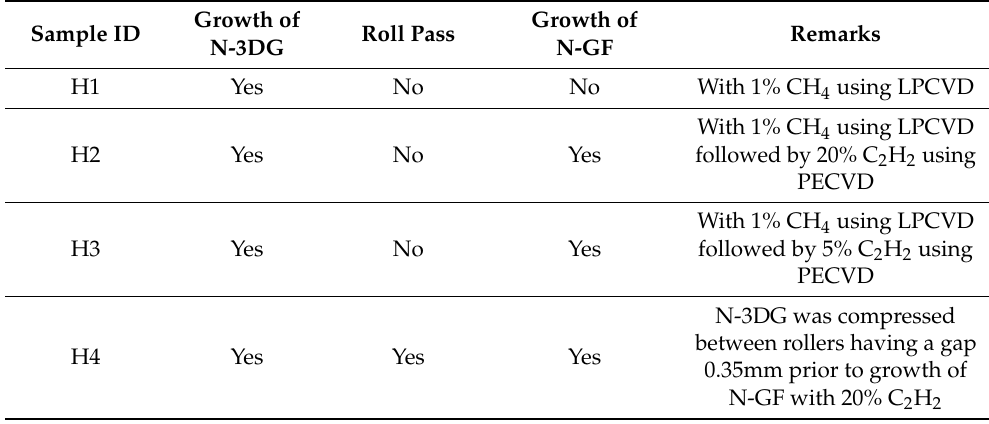
Table 1. Experimental matrix for growth of N-doped 3D graphene hybrid